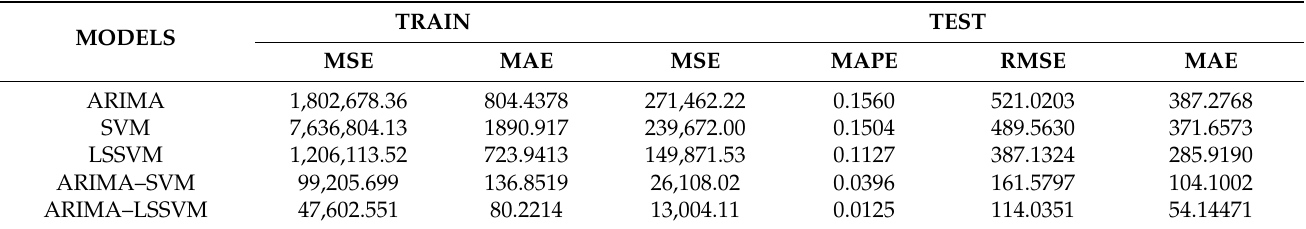
Table 9. Performance measures of the proposed model for daily new recovered COVID-19 cases